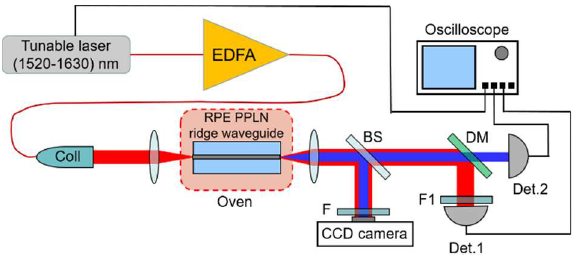
Fig. 2. Experimental setup for SHG characterization of RPE PPLN ridge waveguides. EDFA: erbium-doped fiber amplifier, Coll: collimator, BS: beam sampler, F, F1: filters, DM: short- pass dichroic mirror, Det.1 and Det.2: germanium and silicon power meters, respectively.